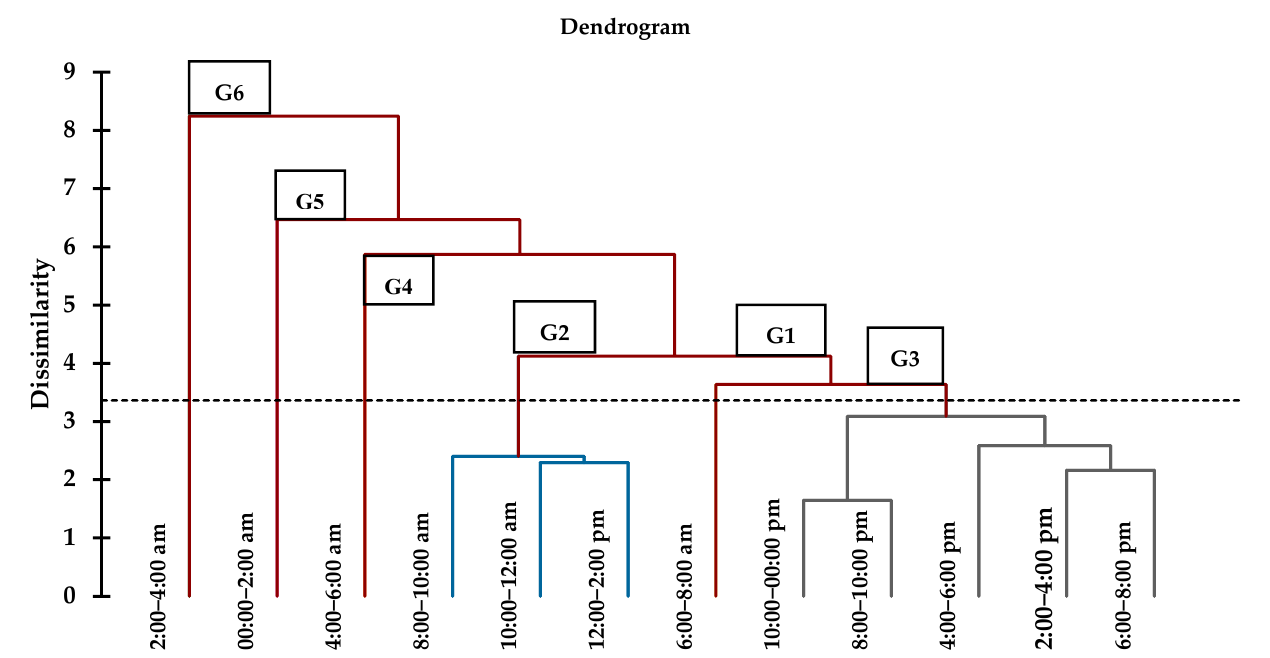
Figure 4. Hierarchical cluster analysis based on all studied traits during the day and night of S. officinalis. (G1 (group 1), G2 (group 2), G3 (group 3), G4 (group 4), G5 (group 5), and G6 (group 6)). The dashed line in the dendrogram was inserted automatically using the partitioning algorithm by the XLSTAT software.